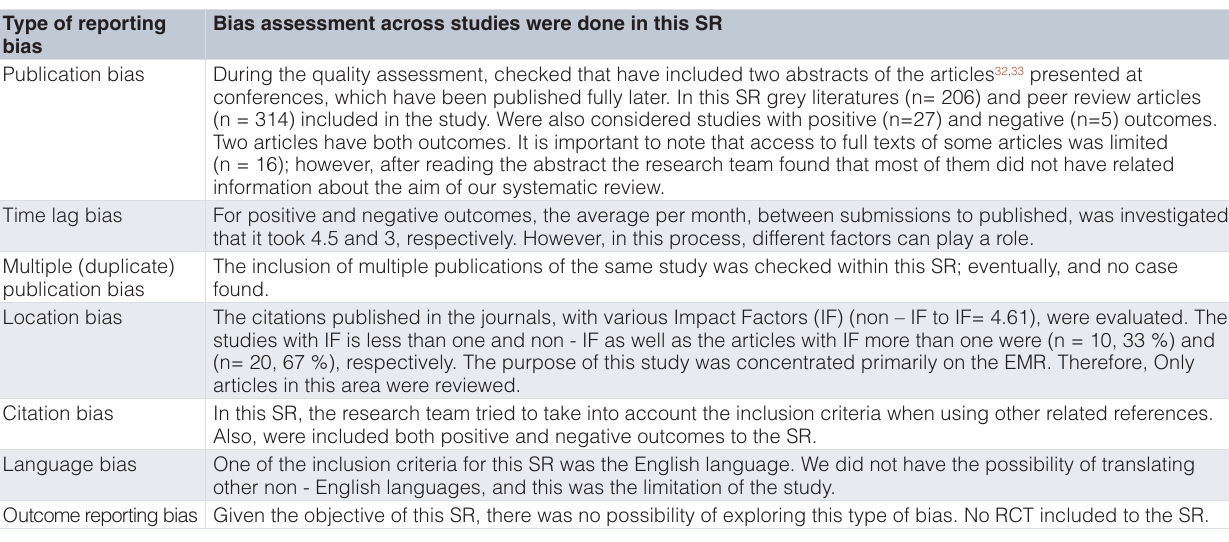
Table 1. Different types of reporting biases in the SR of preparedness components of health systems in the EMR for effective response in DSS. Type of reporting